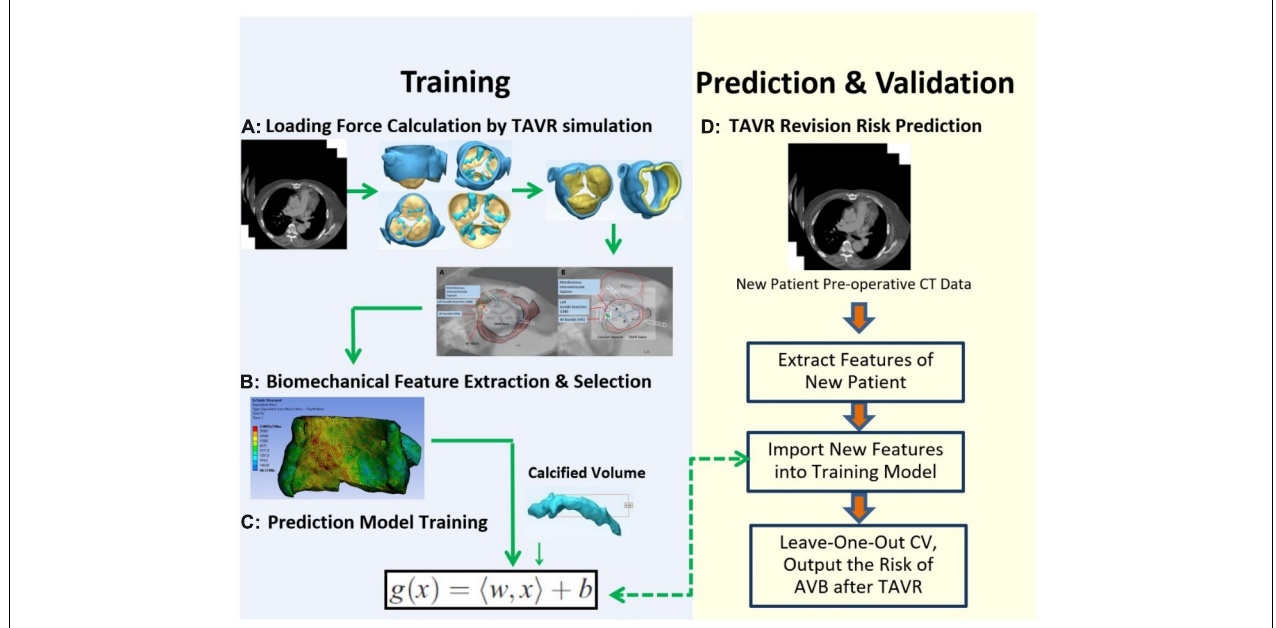
FIGURE 2 | Workflow for AVB